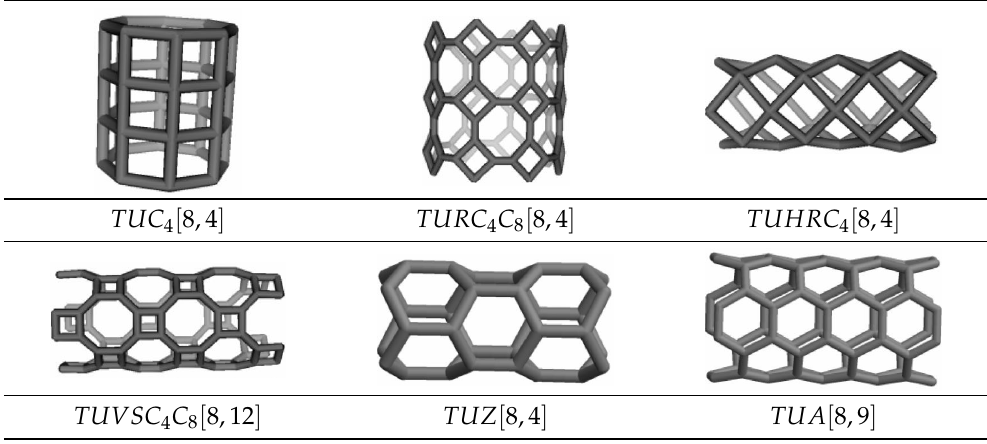
Table 6. Some finite-dimensional carbon